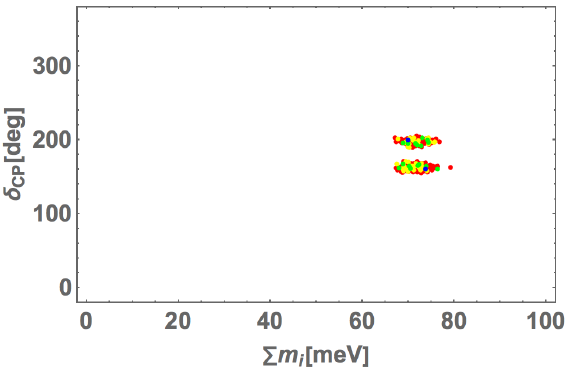
Figure 2 . The left (right) plot shows allowed region of Arg[ (cid:15) legends are the same as the one in figure 1.